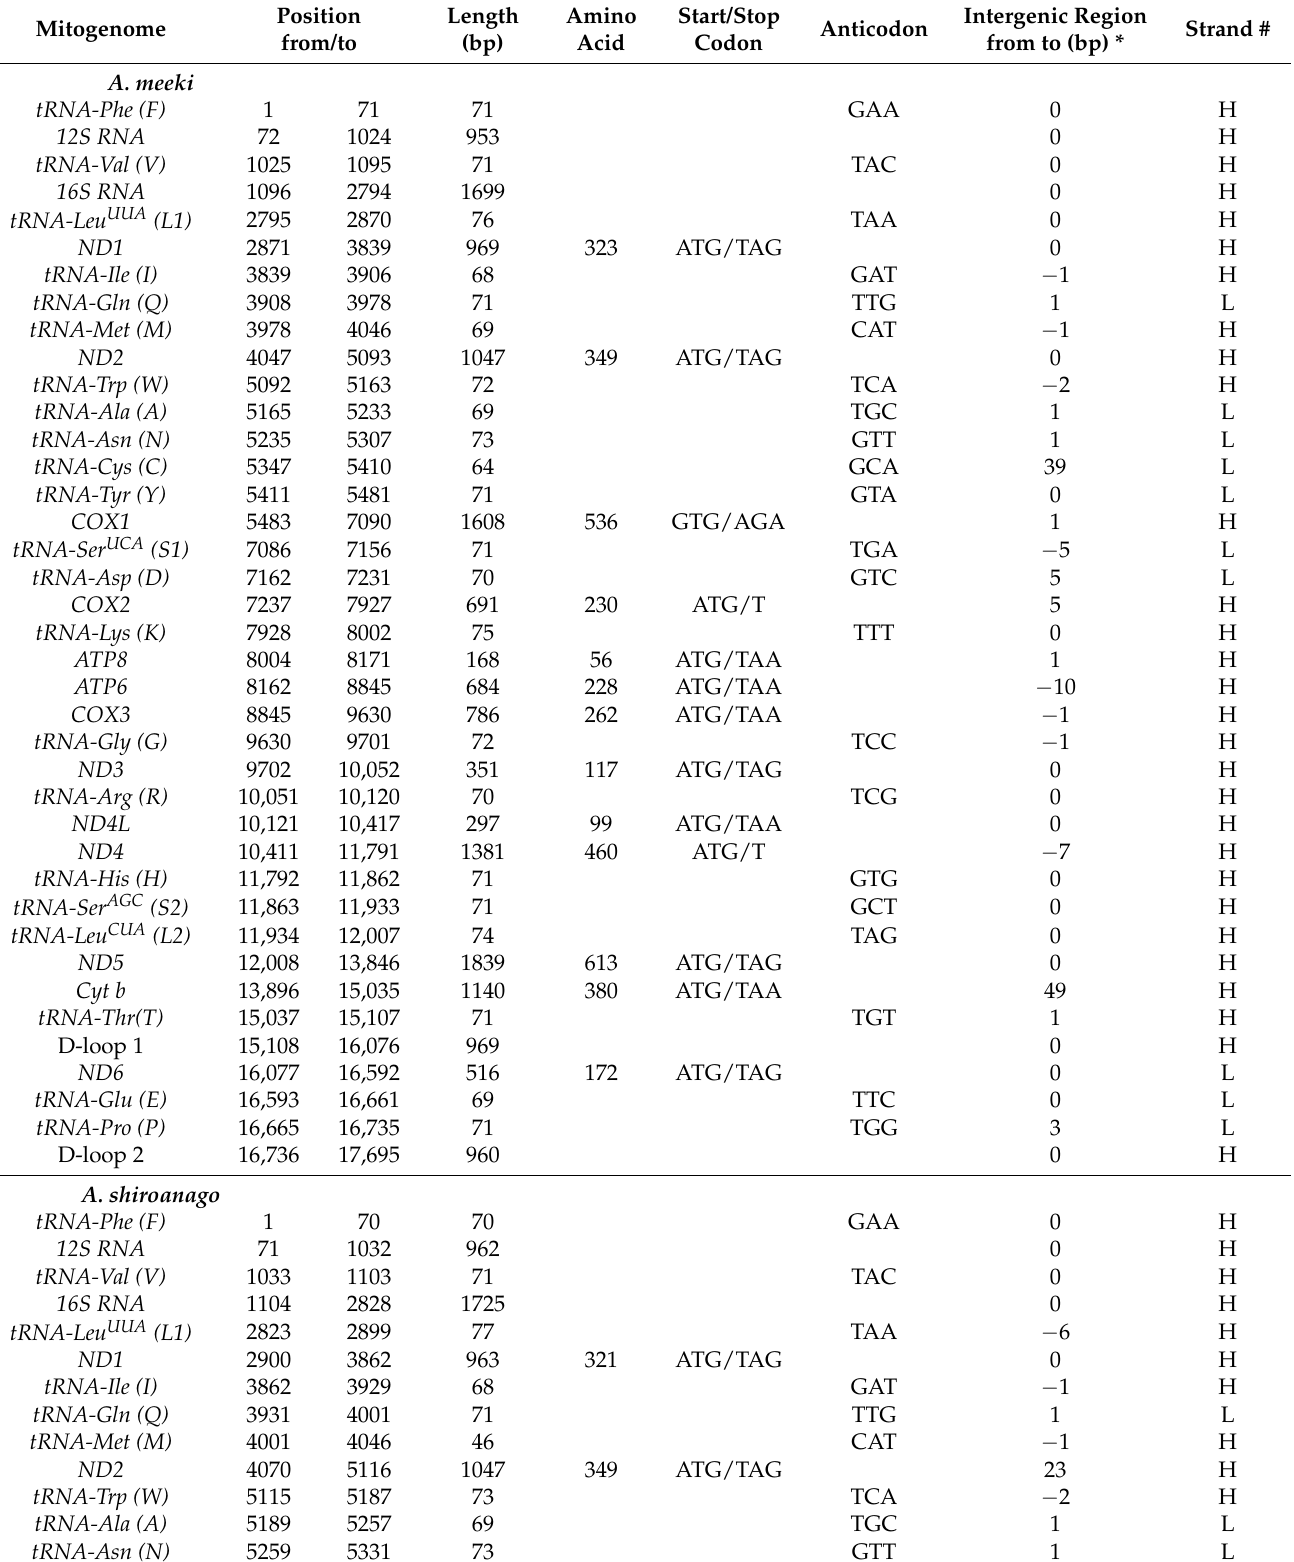
Table 2. Features of the mitochondrial genomes of A. meeki and A. shiroanago